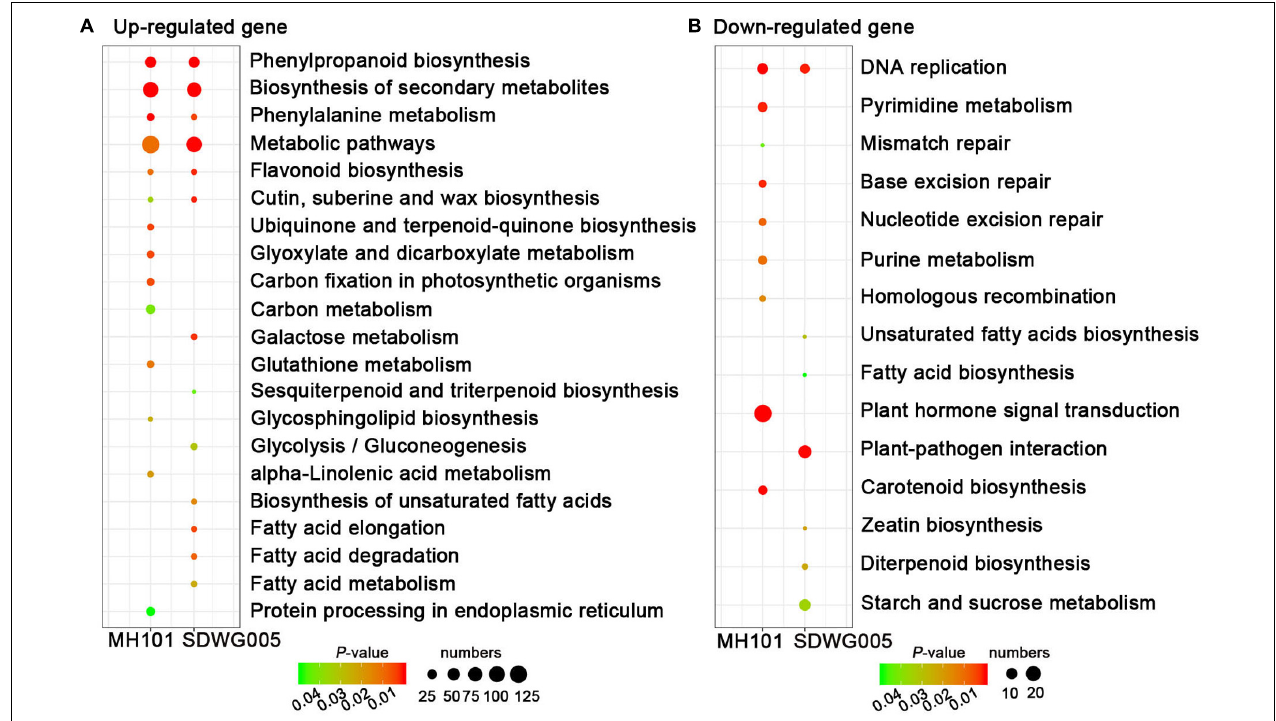
FIGURE 6 | The KEGG pathway enrichment scatter plots of DEGs. KEGG pathway enrichment analyses for up-regulated (A) or down-regulated genes (B) , respectively. Significance is indicated by color, and the number of DEGs is indicated by the size of a circle.